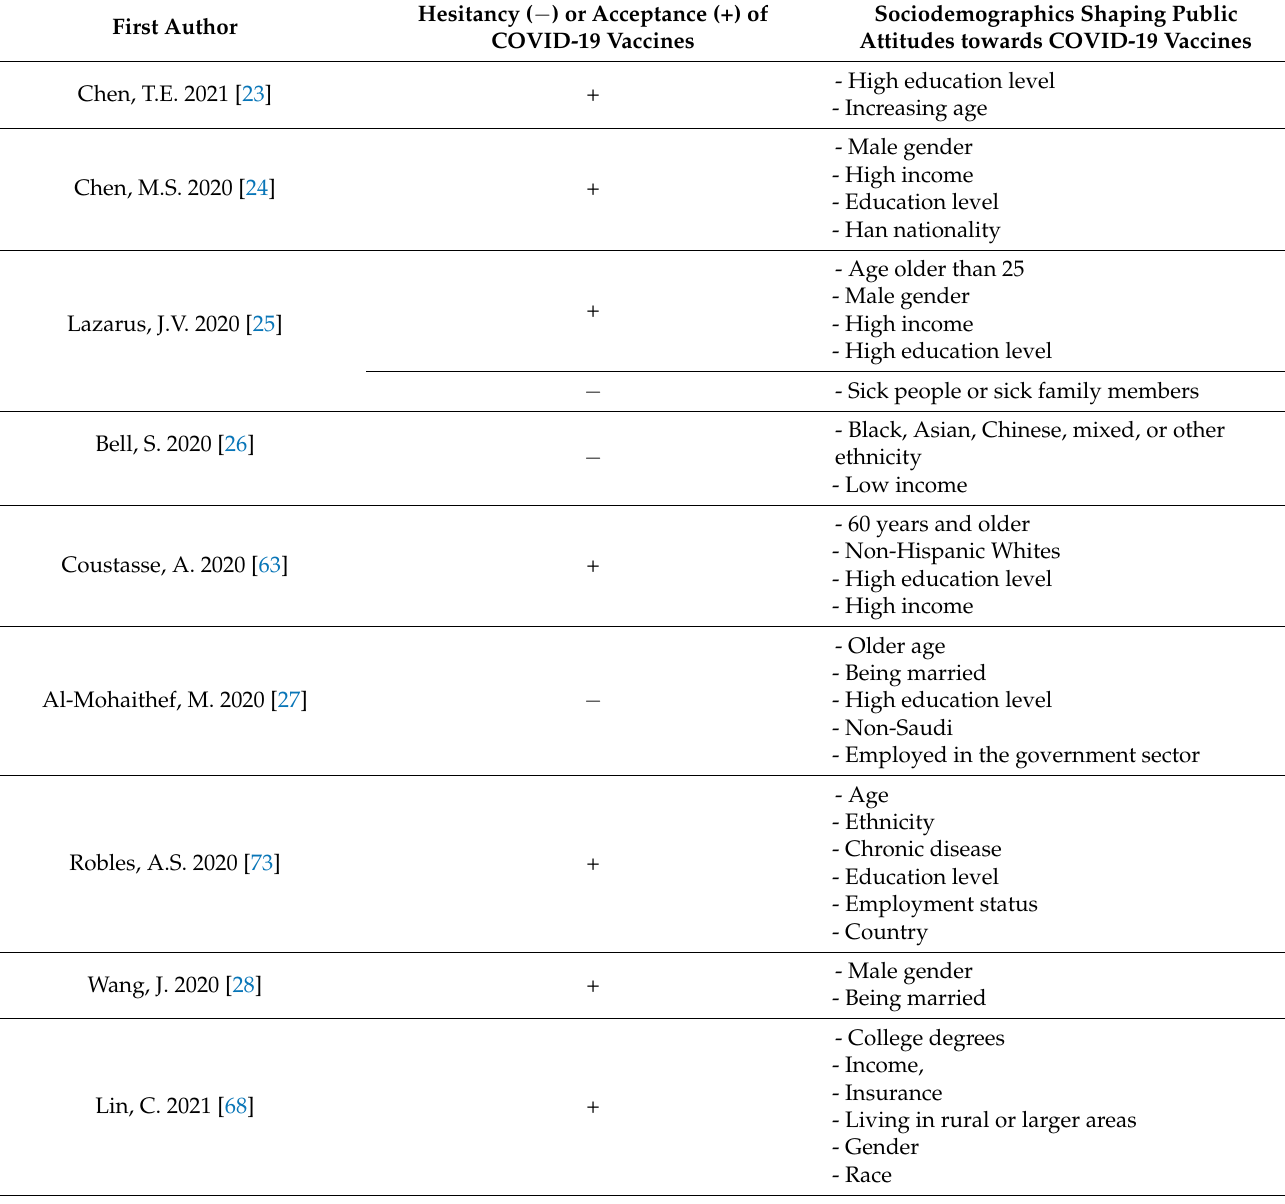
Table 3. Sociodemographic characteristics associated with hesitancy or acceptance of COVID-19